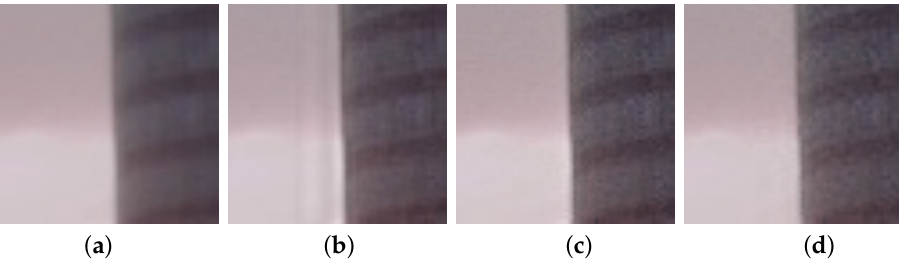
Figure 5. Edge image enhancement. ( a ) The original edge image. ( b ) The image enhanced by MESM. ( c ) The image enhanced by CWM. ( d ) The image enhanced by the proposed method.